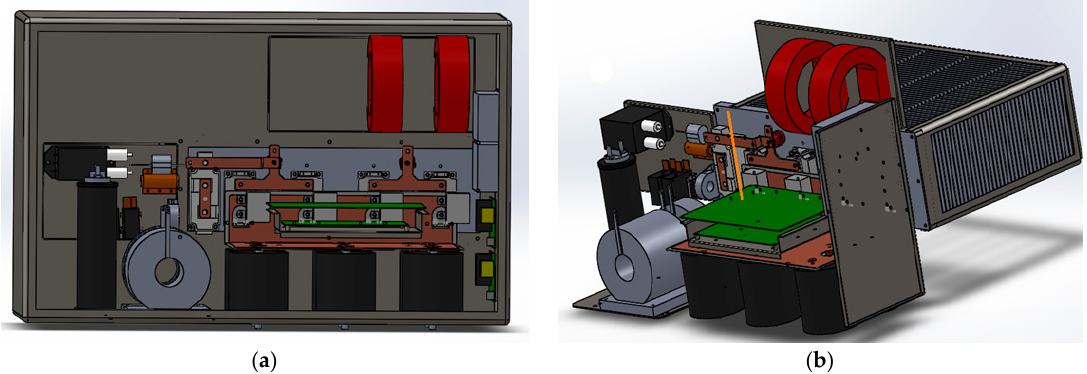
Figure 2. Electro-mechanical concept diagram of DPFC. ( a ) Front view of DPFC, and ( b ) Lateral view of DPFC.